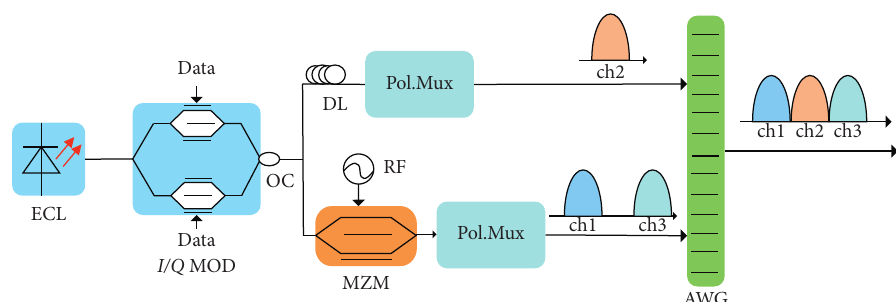
Figure 15: Schematic diagram of optical multicarrier signal generation.